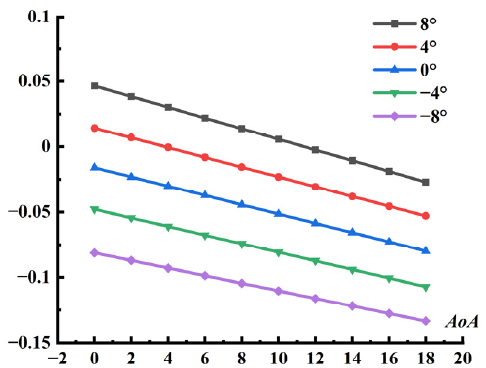
Figure 8. Pitch moment coefficient based on the new CG.